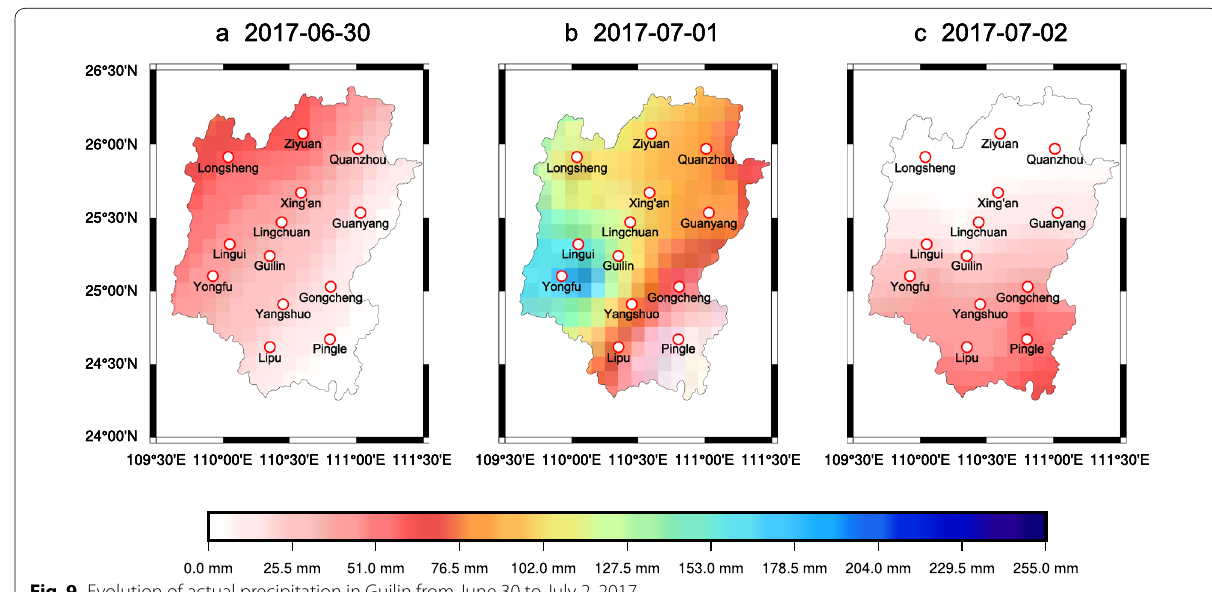
Fig. 9 Evolution of actual precipitation in Guilin from June 30 to July 2,